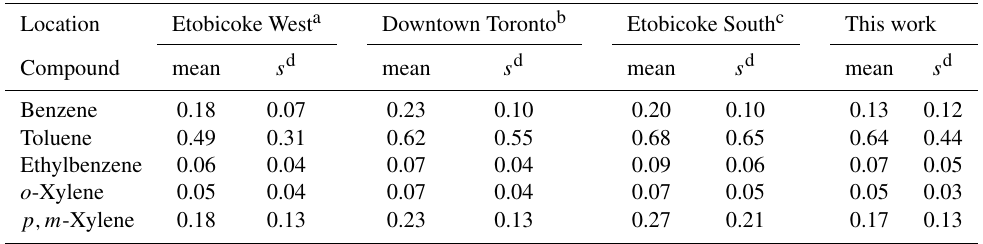
Table 3. Average mixing ratios (nmol mol − 1 ) calculated from data reported by the National Air Pollution Surveillance Program (NAPS) for three locations in Toronto during the time periods covered in this work.